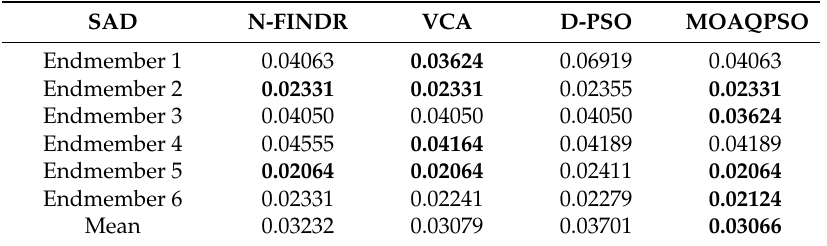
Table 1. Comparison between the Spectral Angle Distance (SAD) values of N-FINDR, Vertex